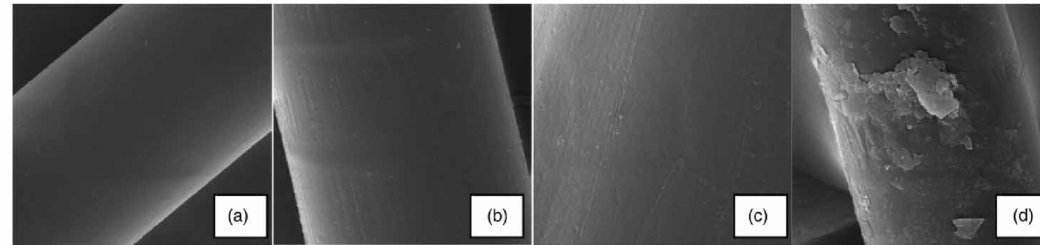
( b ) after solubility assay in HCl, ( c ) after solubility assay in NaOH, ( d ) after use as filtering material for 3 months